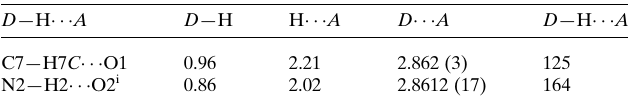
Table 1 Hydrogen-bond geometry (A˚ , (cid:2) ).